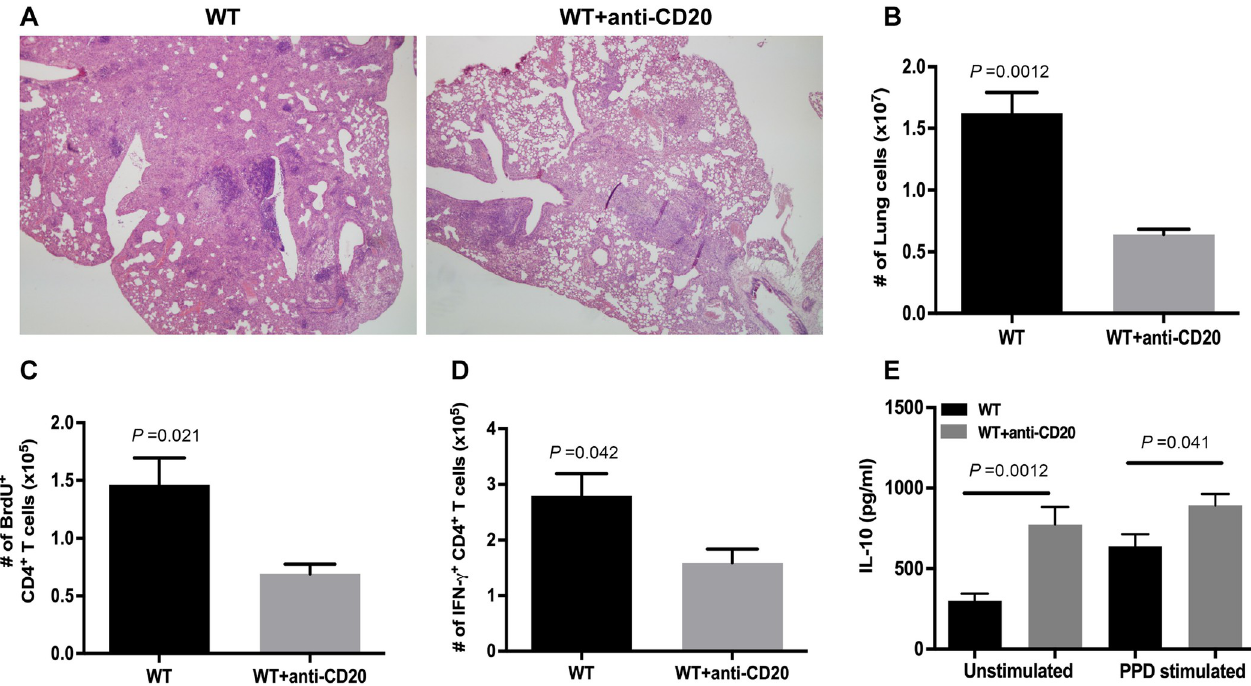
Fig 5. B cell-depleted WT C57BL/6 mice also exhibit diminished granulomatous inflammation and Th1 response and enhanced IL-10 levels in the lungs during chronic M . tuberculosis infection. Mice were treated with the anti-CD20 mAb 5D2 beginning 2 days prior to a low-dose (100 CFU) aerogenic challenge with M . tuberculosis Erdman, as described in "Materials and Methods". B cell depletion was maintained throughout the duration of the experiment. The control mouse group (WT) received non-specific rat IgG. The lung tissues were examined at 5 months post-infection. The levels of granulomatous inflammation response were analyzed histologically by light microscopy on H&E-stained lung sections (A) and enumeration of total number of lung cells (B). The level of lung CD4 + T cell response was assessed by in vivo BrdU labeling to examine the proliferation capacity of this T cell subset (C), as well as by enumeration of IFN- γ -producing CD4 + T cells (D). Ex vivo evaluation of lung cells for the level of IL-10 production (E) was conducted as described in Fig 4. Four to 5 mice per group were evaluated per group. Data depicted in B, C, D, and E are presented as means ± SEM. The data shown are representative of two experiments. The results demonstrated that the inflammation, Th1 response, and IL-10 phenotypes observed in the μ MT mice are recapitulated in mice depleted for B